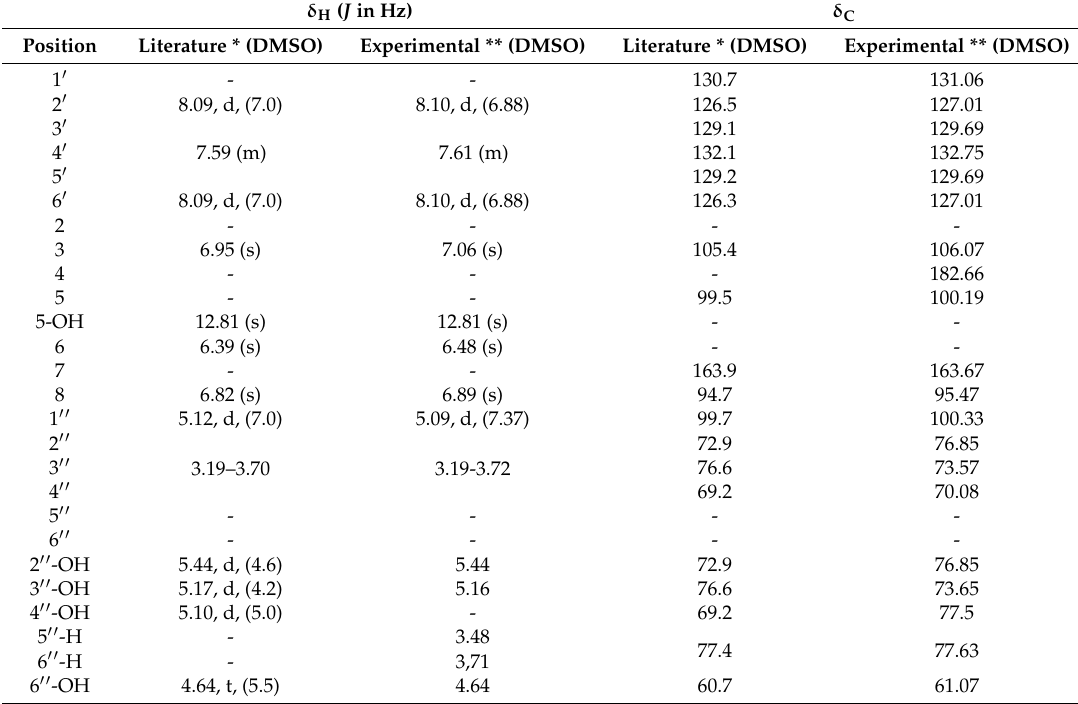
Table 2. 1 H-NMR and 13 C-NMR data of chrysine-7- O - β - D -glucopyranoside ( 3 ) [14]. δ H ( J in Hz) δ C